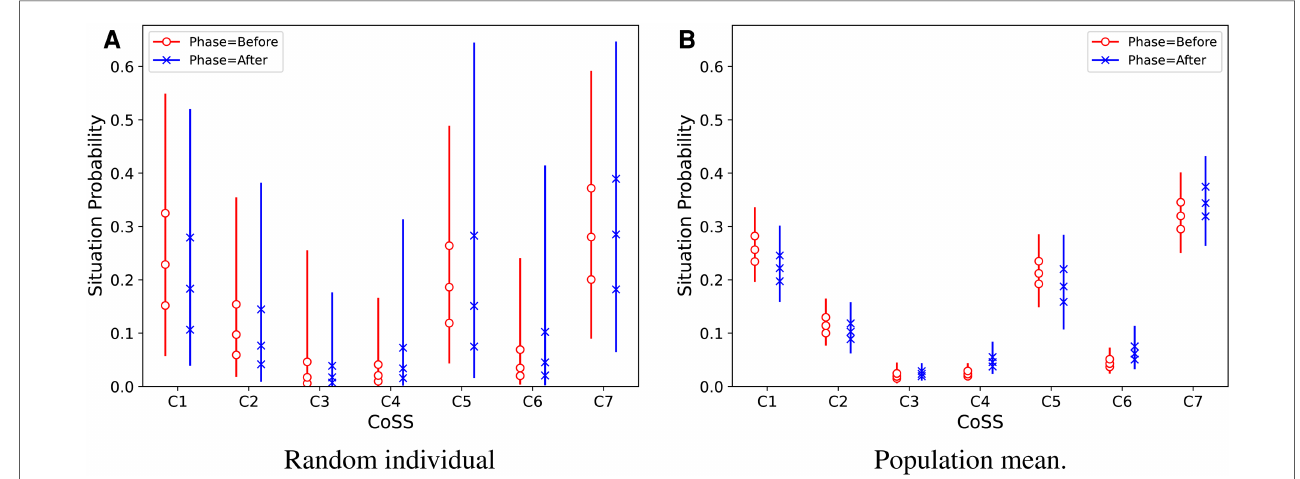
FIGURE 6 Predictive results for the situation probabilities estimated for a random individual in the population ( A ) and for the population mean ( B ). Vertical lines show 95% credible intervals of the marginal distributions for each category. Marker symbols show 25-, 50-, and